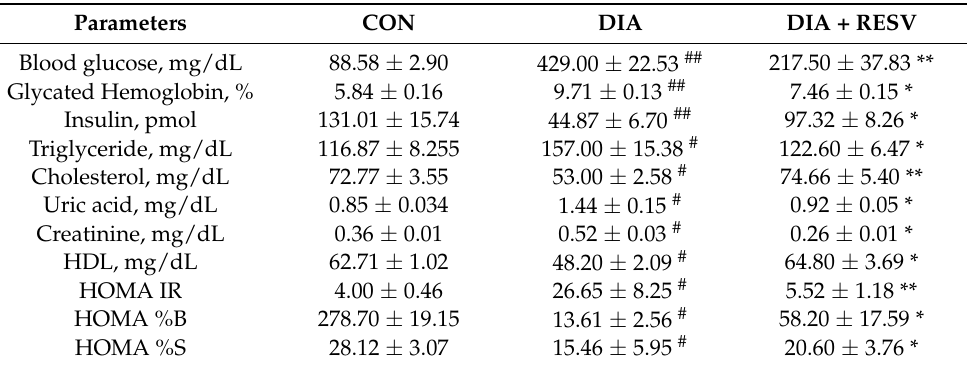
Table 1. Serum biochemistry of diabetic and resveratrol administered rats.